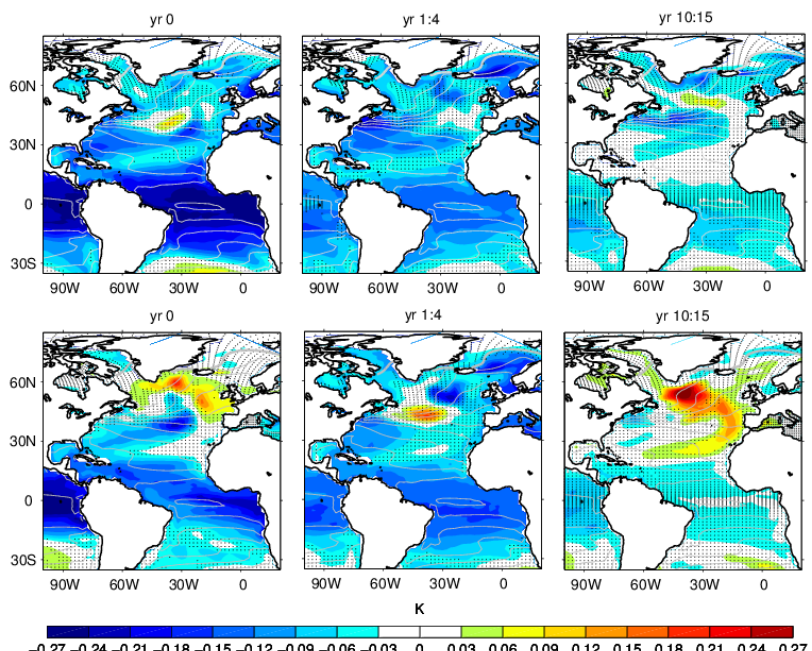
Fig. 7. Composites of anomalous sea surface temperature following volcanic eruptions in different periods. Top: between 1100 A.D. and 1300 A.D., bottom: after 1400 A.D. Dotted areas are not significant at the 5% level. Grey contours show the annual mean SST. Contour interval is 3K, the thick line is for the zero